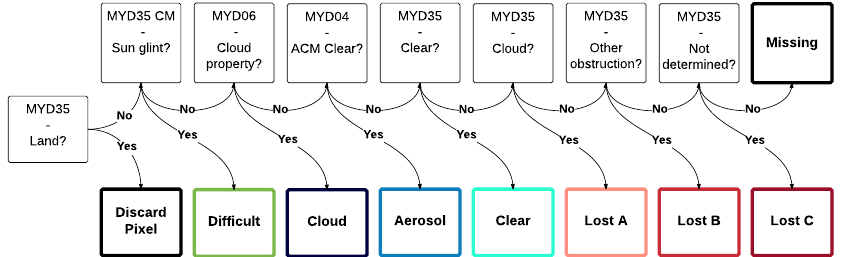
Figure 1. Classification procedure applied to the Moderate-Resolution Imaging Spectro-Radiometer (MODIS) data; colors of each class are used in the example scene in Figure 2c.